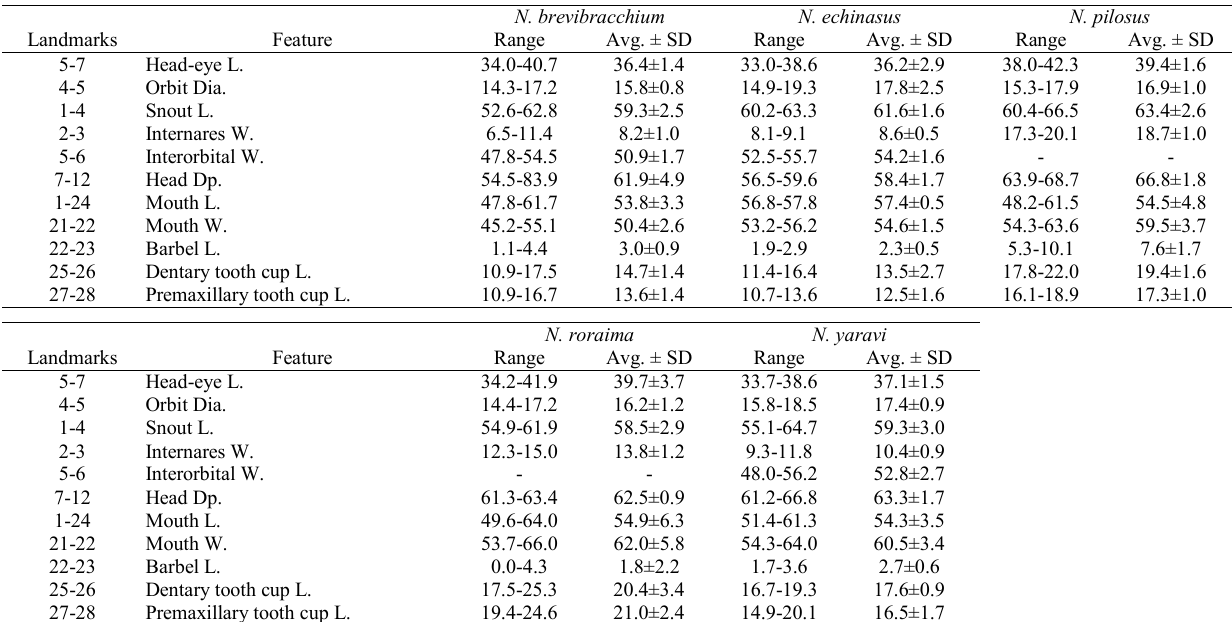
Internares W. Interorbital